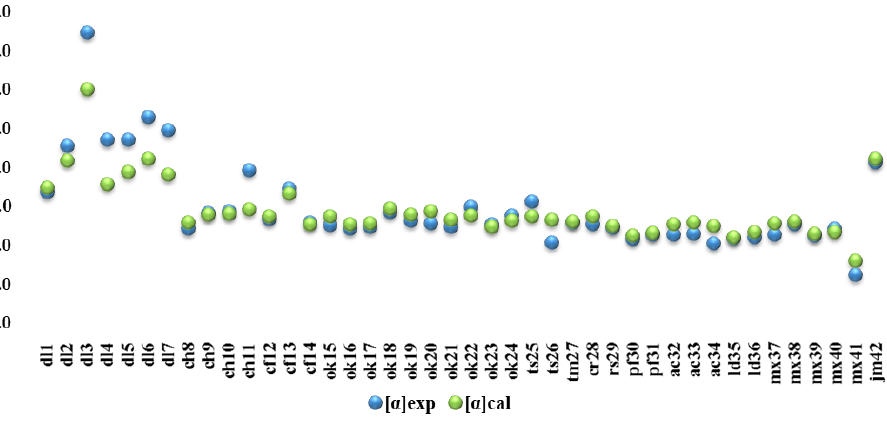
Figure 3. Calculated [ α ]cal and experimental [ α ]exp values of specific angle of 41 samples of honey and one sample of jam.